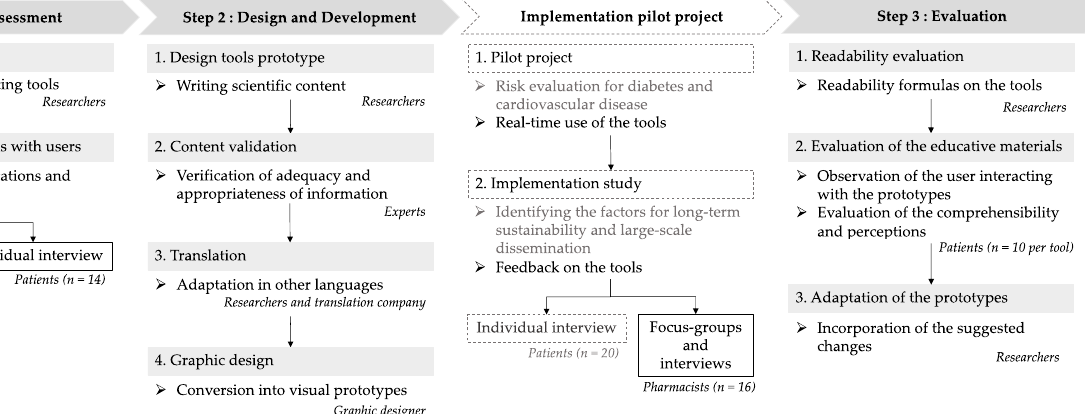
Figure 1. Overview of the different stages of the development and design process. Notes: Descriptive details on the methodology of the risk assessment project and the results of the implementation study (dotted lines in the graph) are presented in a separate article [12].